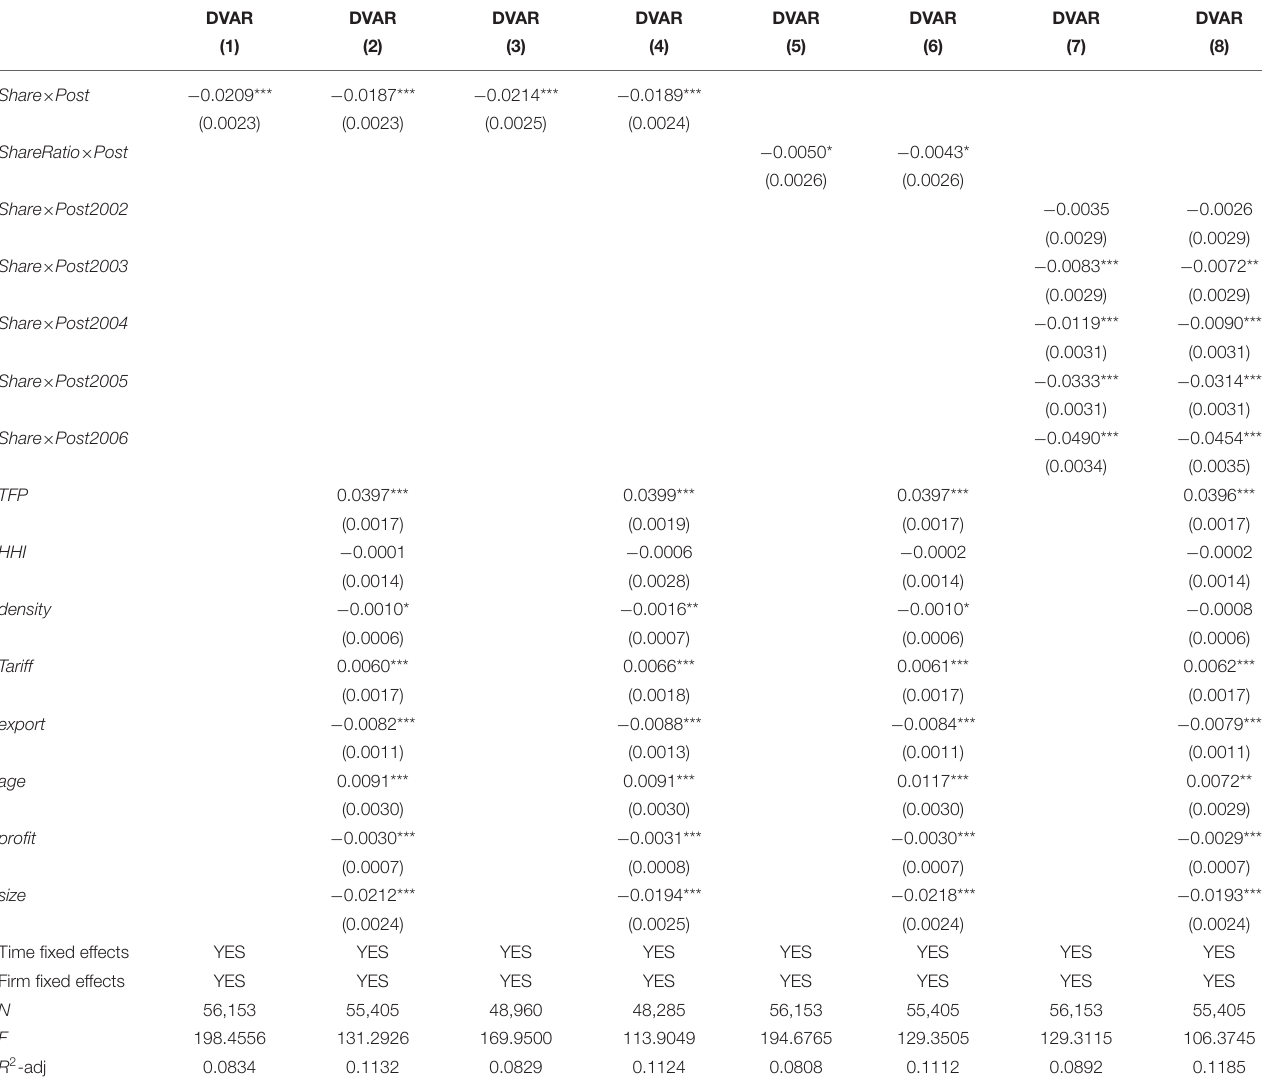
TABLE 2 | Impact of tax sharing reform on the domestic value-added rate (DVAR) of